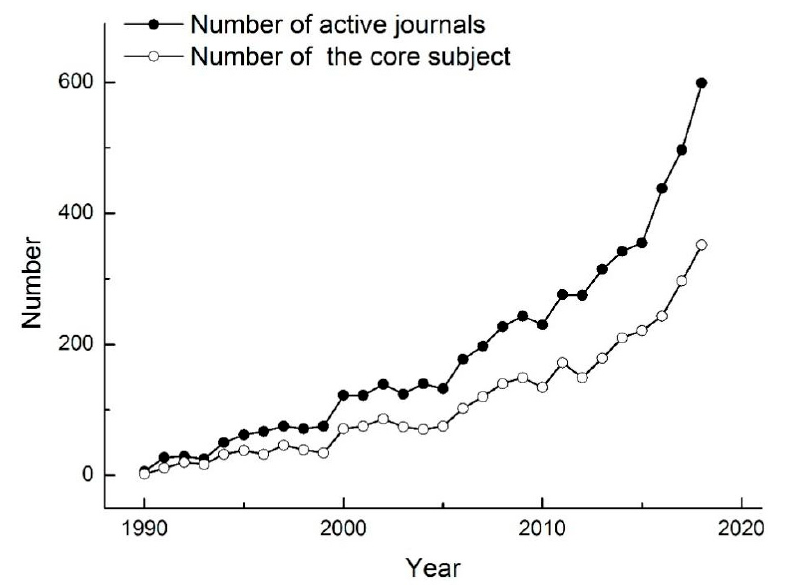
Figure 1. The number of published studies on the prediction of air pollutants and its main disciplines from 1990 to 2018.